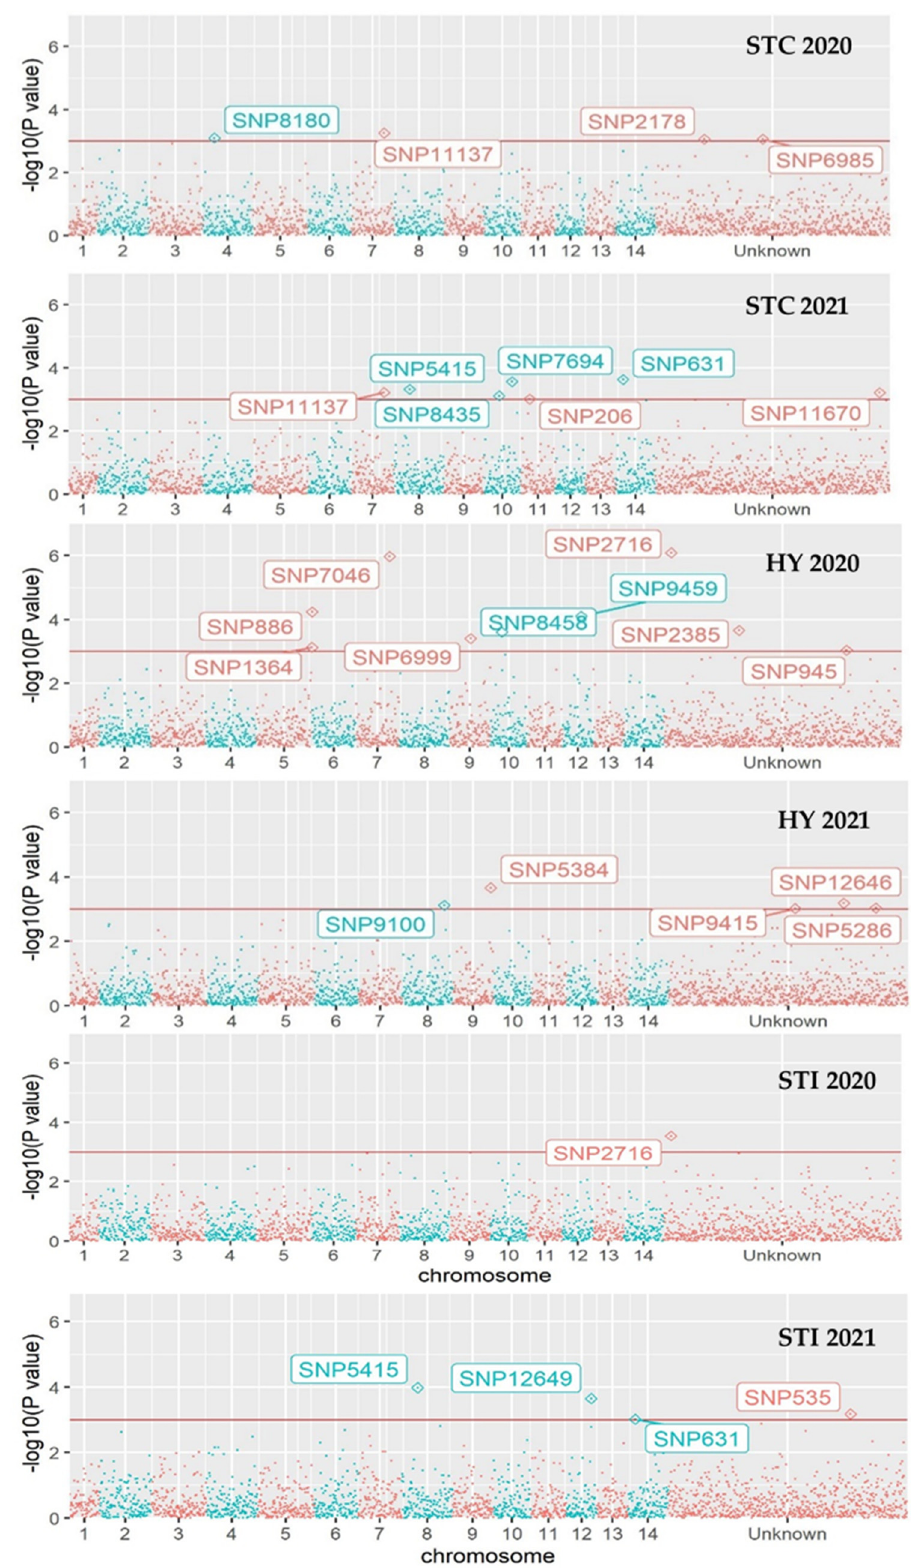
Figure 3. Manhattan plots showing distribution of SNPs across the macadamia genome and significance of marker–trait associations for three traits in 2020 and 2021 in the M. integrifolia panel. STC = log e (count of stick-tights), HY = log e (harvestable yield (count of nuts)), STI = logit(stick-tight incidence (STC/(STC + HY)).